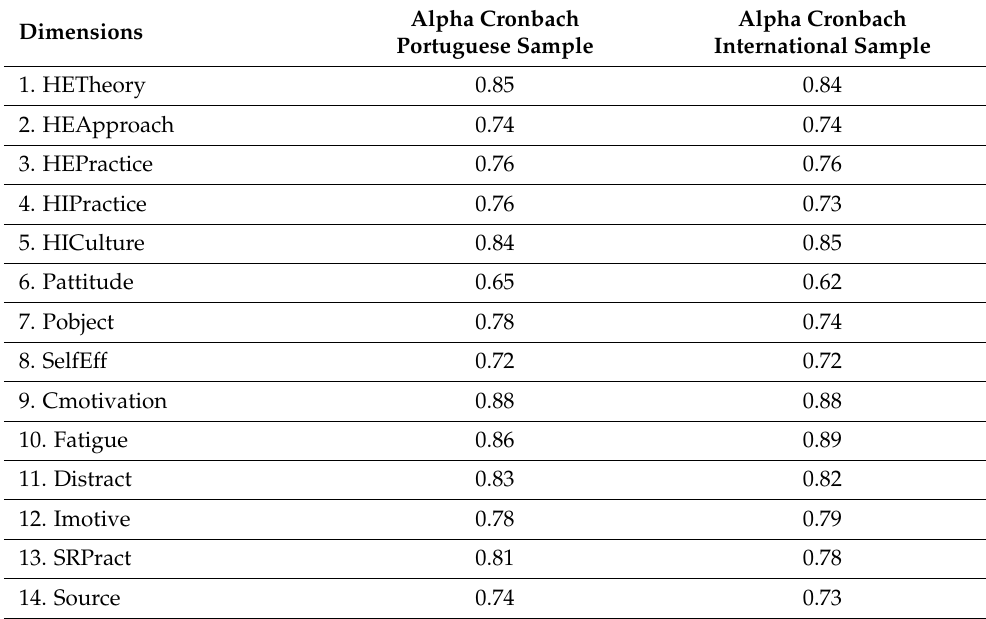
Table 3. Reliability of the InovSafeCare instrument in Portuguese and international sample.